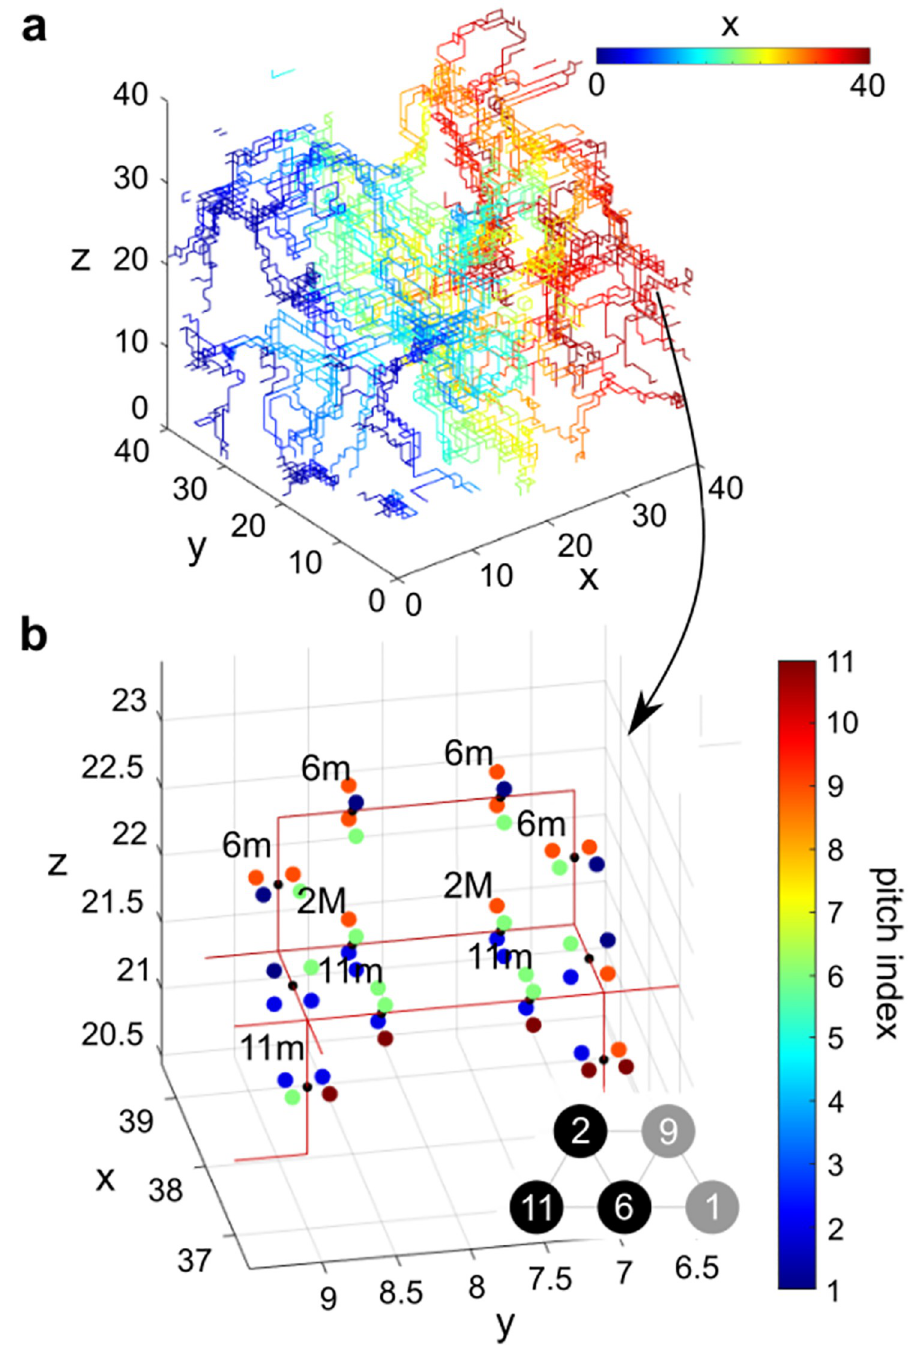
Fig 7. Vortex strings in the quenched state. (a) Network of vortex strings in the quenched state of a simulation run with τ Q = 1638 t 0 . Color gradient is applied along the x-axis to improve clarity. (b) Zoom in of a small region of (a), showing vortex strings in red. Pitches surrounding the vortex at each string segment are indicated by four colored dots around the string segment. Vortices corresponding to major or minor triads are labeled by the root pitch index and M or m respectively. Inset shows a portion of the Tonnetz spanning the pitches appearing in (b).